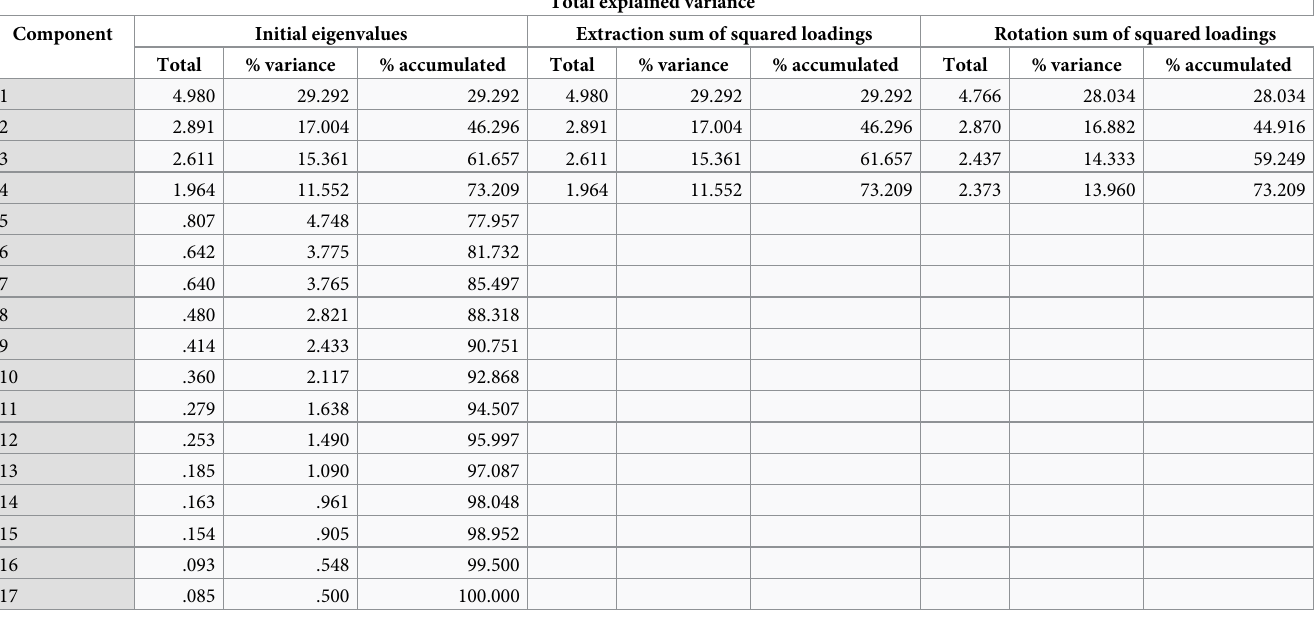
Total explained